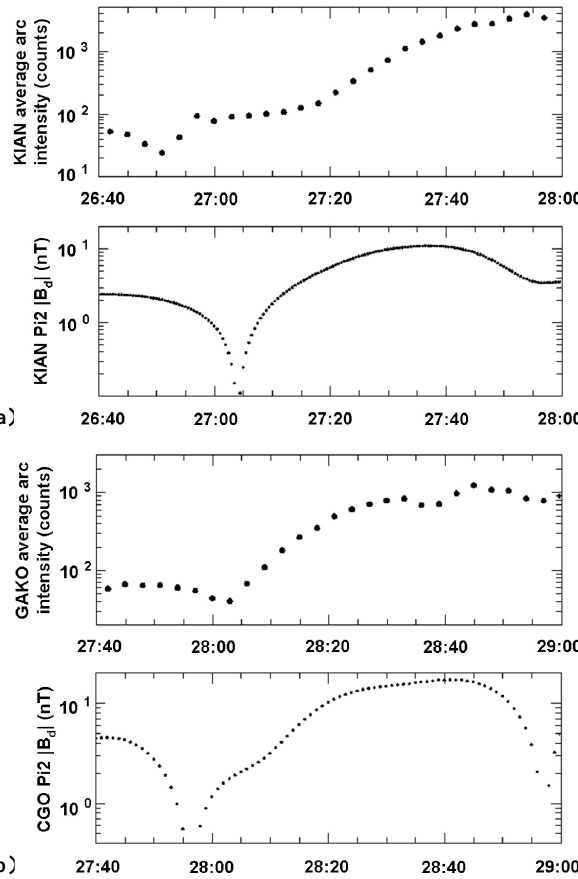
Fig. 12. (a) The temporal correlation between the intensity growth of the substorm initiation arcs observed by KIAN ASI and the ab- solute value of the Pi2 D-component magnetic field observed by the ground KIAN magnetometer which is just underneath the breakup arc. (b) The temporal correlation between the intensity growth of the substorm initiation arcs observed by GAKO ASI and the abso- lute value of the Pi2 D-component magnetic field observed by the ground CGO magnetometer which is just underneath the breakup